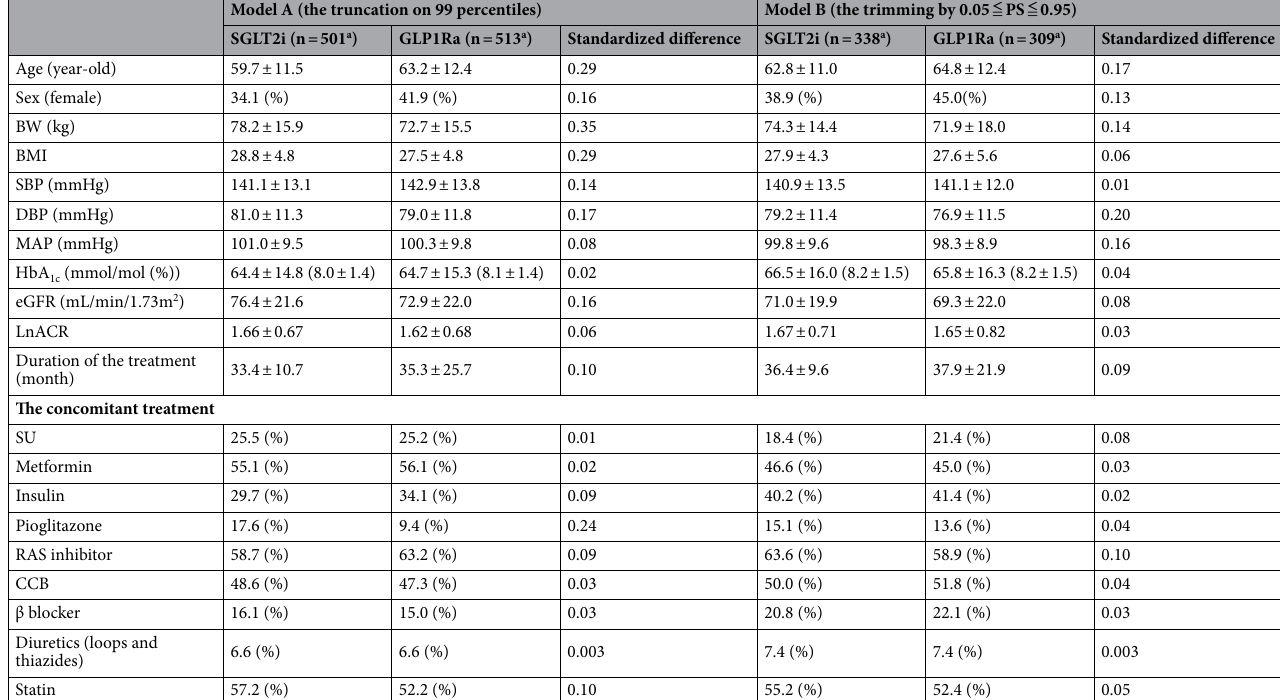
Table 2. The clinical characteristics of SGLT2i-treated and GLP1Ra-treated patients after ATE weighting. Values represent the mean ± standard difference, or n (n/total %). ATE average treatment effect, BMI